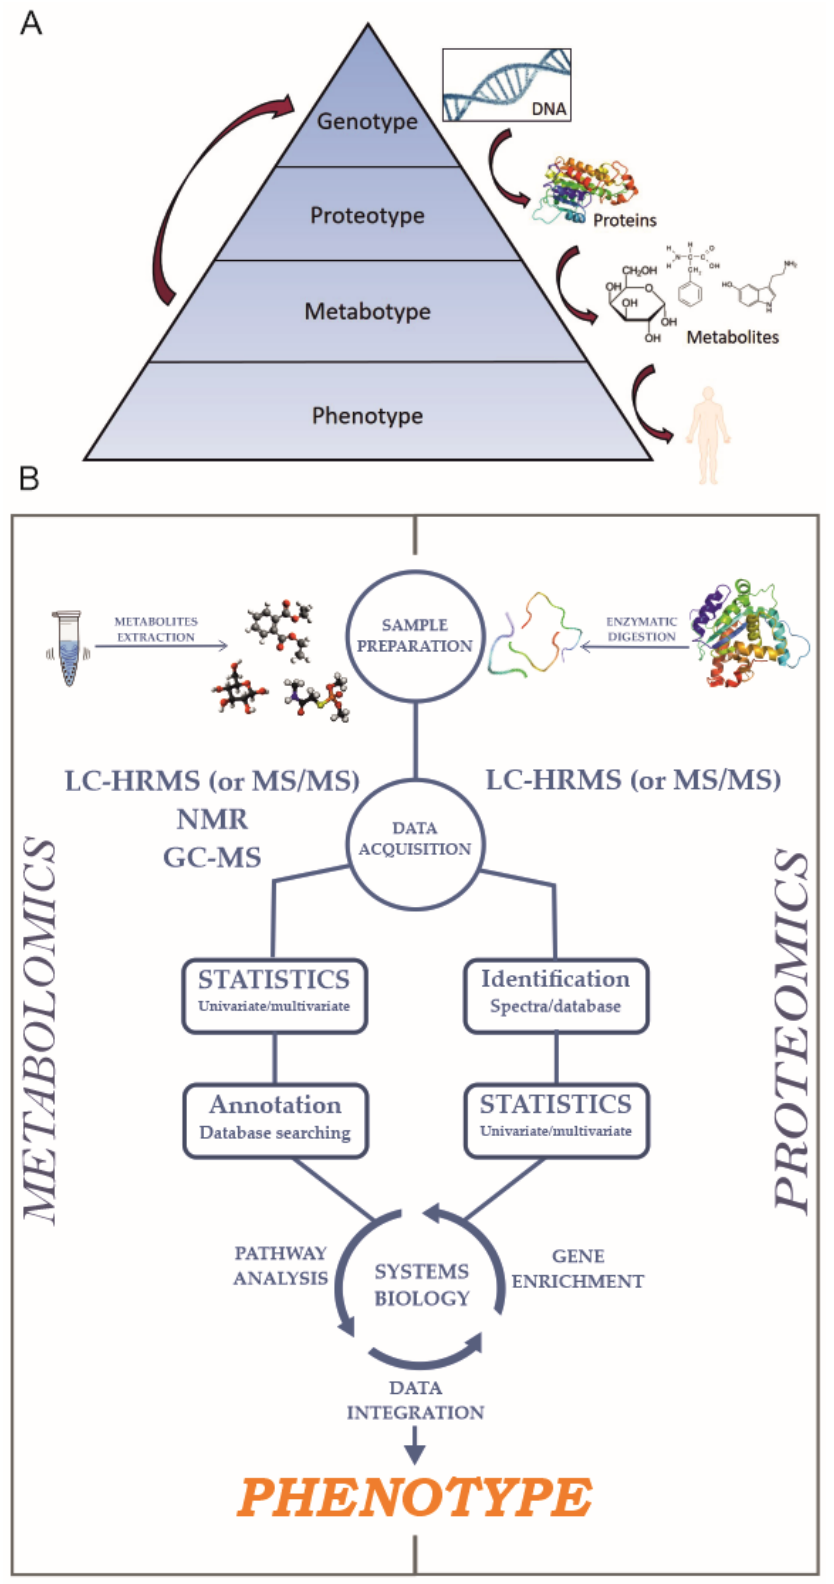
Figure 1. ( A ) Cartoon showing the pathway from the genotype to the phenotype. ( B ) Schematic representation of untargeted proteomics and metabolomics workflows.